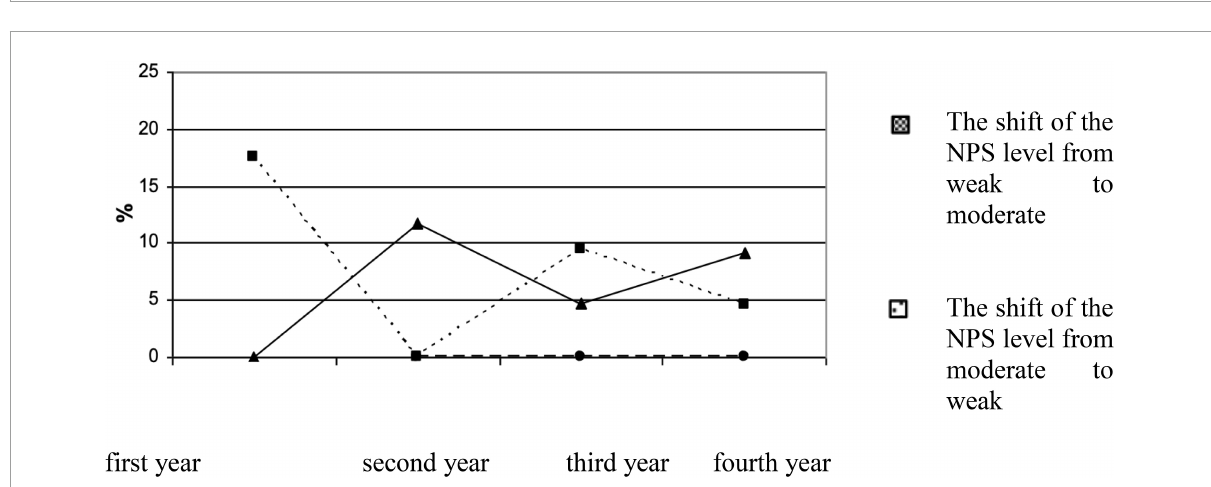
FIGURE6 Frequency of occurrence of different dynamics patterns in the level of neuropsychic strain in psychology students of the second age subgroup from the beginning to the end of classes (in